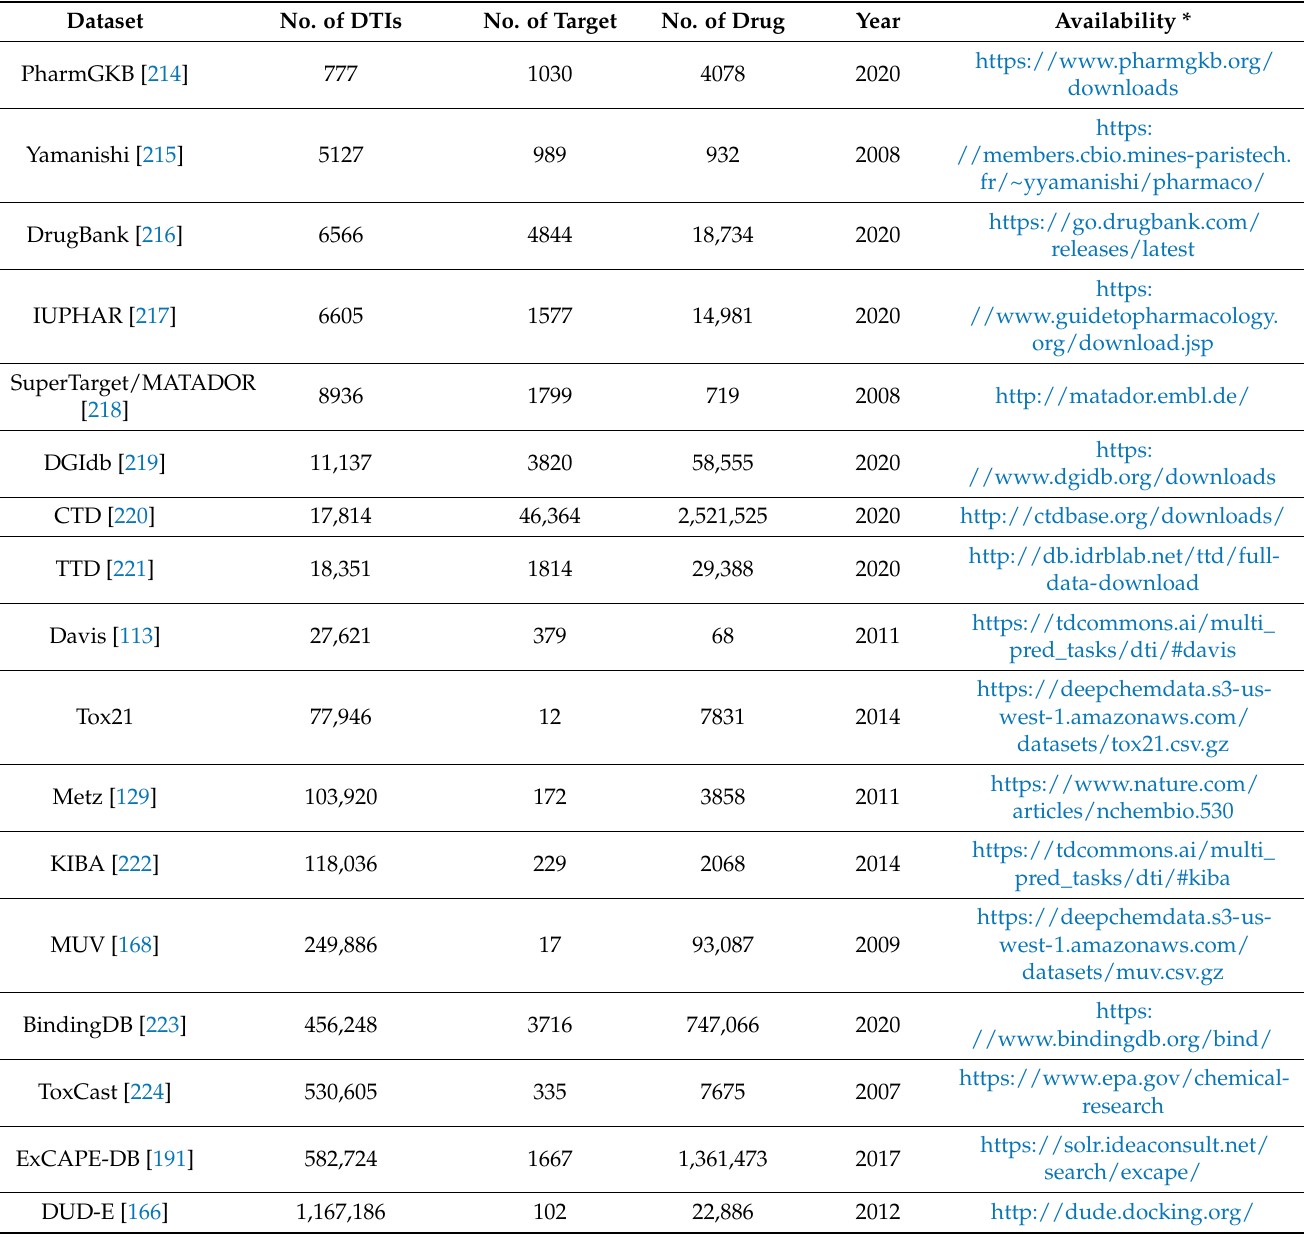
Table A4. Benchmark datasets for